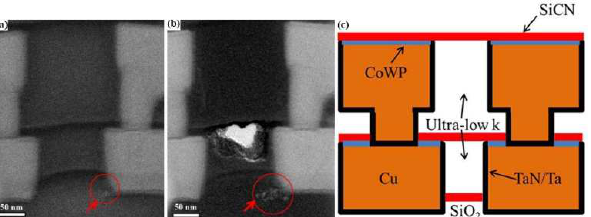
Figure 8. Electron spectroscopic imaging (ESI) analysis of the Cu distribution after the electrical test of ( a ) 20 V/106 min + 25 V/638 min and ( b ) 20 V/106 min + 25 V/872 min. ( c ) is the schematic structure of ( a , b ). The structure consists of Cu interconnects in M1 and M2 metal layers, which are encapsulated by a TaN/Ta barrier, SiCN capping layer, CoWP top coating, and insulated by ultralow dielectric permittivity material (porous organosilicate glass). Reprinted with permission from ref. [97]. Copyright 2015,